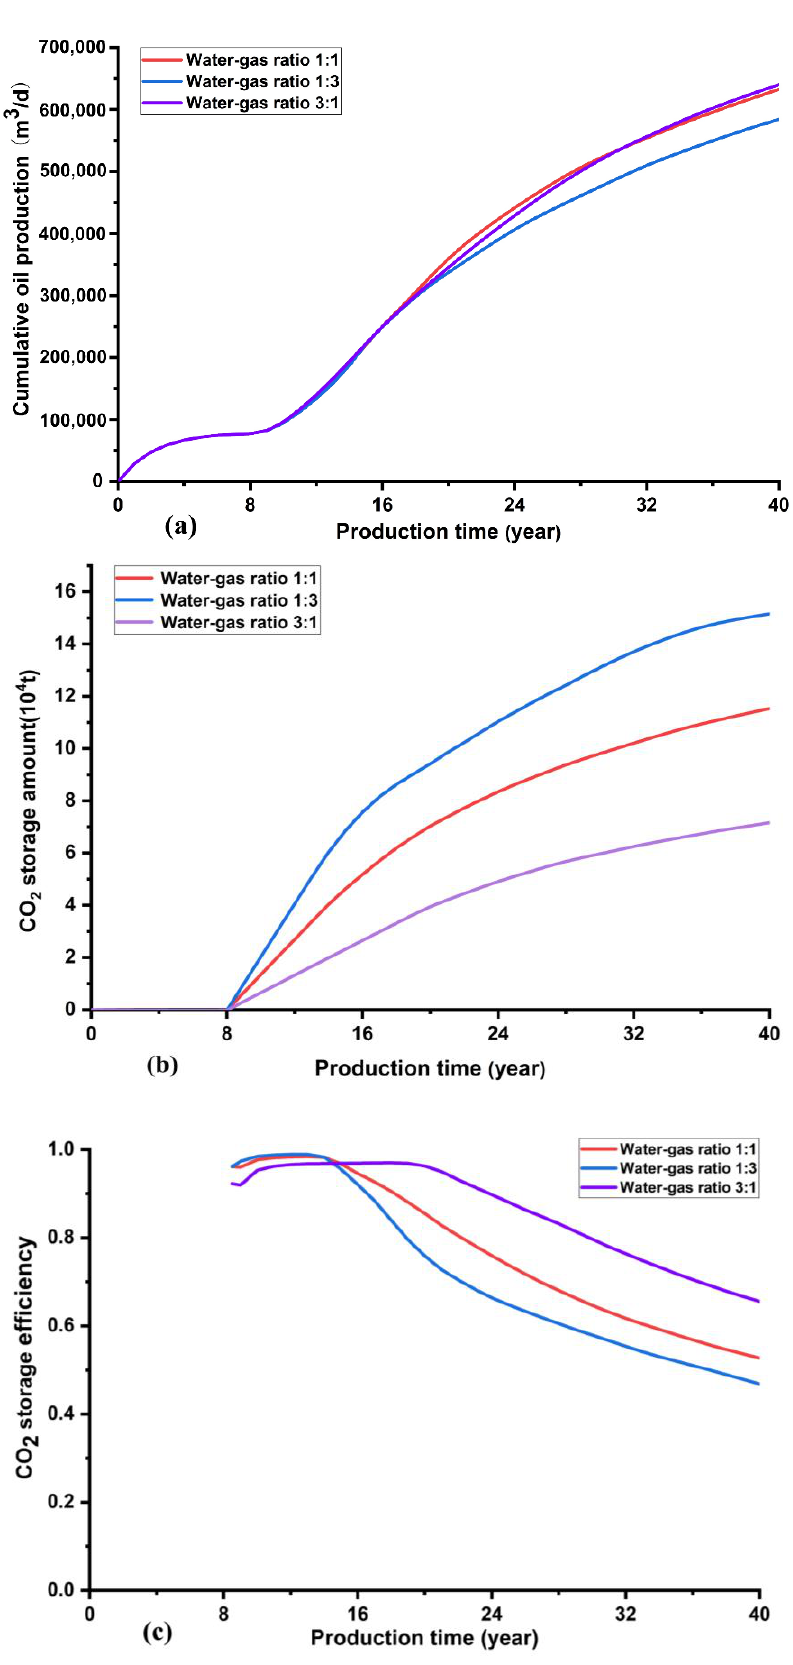
Figure 10. Effect of fluid injection rate on ( a ) cumulative oil production, ( b ) CO 2 storage amount, and ( c ) CO 2 storage efficiency.